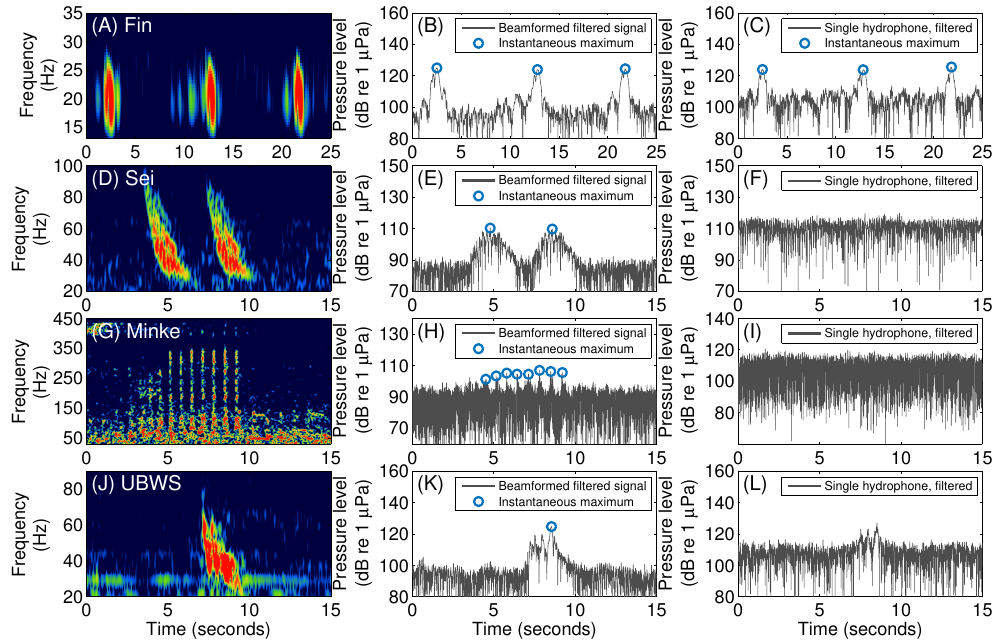
Figure 1. Example vocalizations from ( A – C ) fin whale, ( D – F ) sei whale, ( G – I ) minke whale and ( J – L ) the unidentified baleen whale species. Sub-plots ( A , D , G , J ) show the beamformed spectrogram of the vocalizations from each species. Corresponding beamformed pressure-time series used for plotting the spectrograms are shown in ( B , E , H , K ), respectively. ( C , F , I , L ) show the pressure-time series from a single omnidirectional hydrophone. All signals were bandpass filtered between upper f U and lower f L frequencies defined as − 10 dB end points in power spectrum. The received vocalization pressure levels were estimated from the root-mean-square value of the maximum instantaneous beamformed bandpass filtered pressure-time series. A high gain of up to 18 dB can be achieved after beamforming the data measured on a 64-element sub-aperture of the 160-element hydrophone array, enabling vocalizations from sei whales, minke whales and unidentified baleen whales species to be detected above the ambient noise. In contrast, the sei whale, minke whale and unidentified baleen whale species vocalizations could not be consistently detected on a single hydrophone. For fin whales, since the acoustic wavelengths of the vocalizations are large, the array aperture is not long enough to provide gains larger than 5 dB. The high intensity fin whale 20-Hz pulses are detectable even without coherent